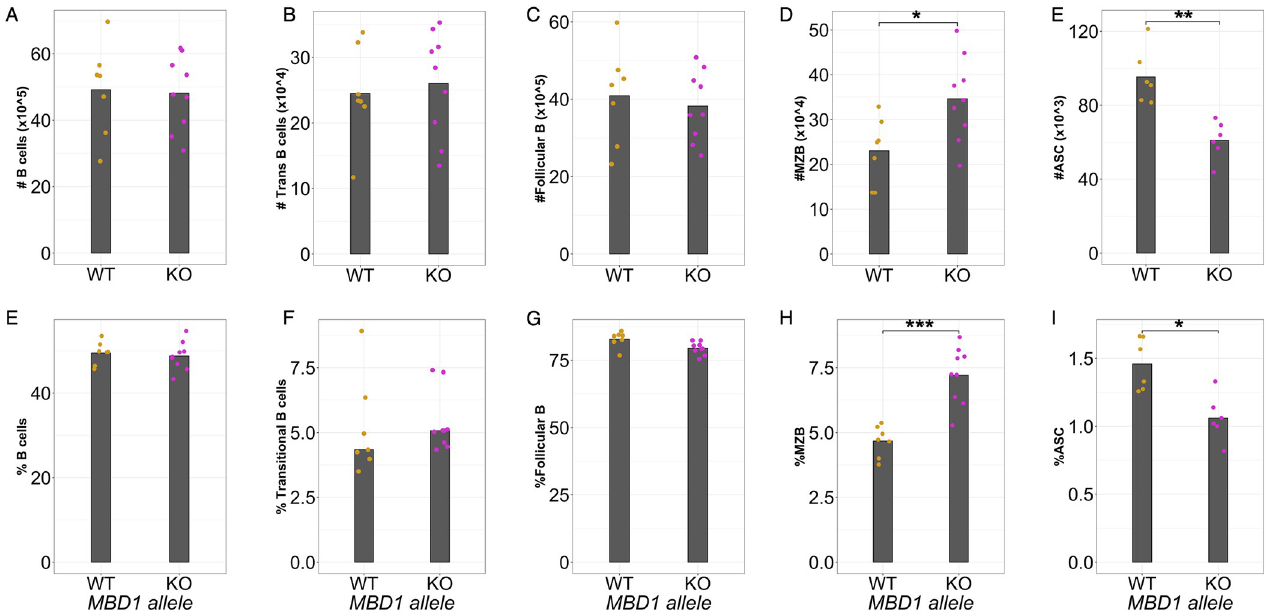
Fig 7. MBD1 regulates B cell subsets at homeostasis. The number and proportion of (A, E) CD19+, B220+ B cells, (B, F) transitional B cells, (C, G) follicular B cells, (D, H) marginal zone B cells, and (E, I) antibody secreting cells were measured in the spleen at baseline The data shown represent one of two independent experiments, each performed with 6–9 animals from each genotype. Each point represents an individual animal measurement, and the grey crossbar indicates the mean for each genotype. ( � p < 0.05, �� p < 0.01, ��� p < 0.001) p-values determined using a Wilcoxon Ranked Sum test.